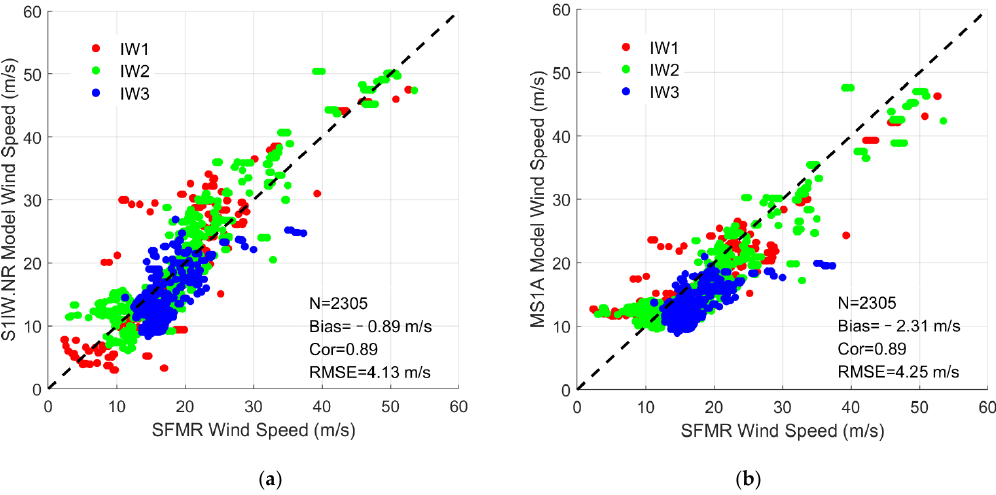
Figure 6. Comparison between the wind speed retrievals and SFMR measurements based on Dataset 2. Wind speeds were retrieved by the ( a ) S1IW.NR model and ( b ) MS1A model. Red, green, and blue points stand for IW1, IW2, and IW3, respectively.